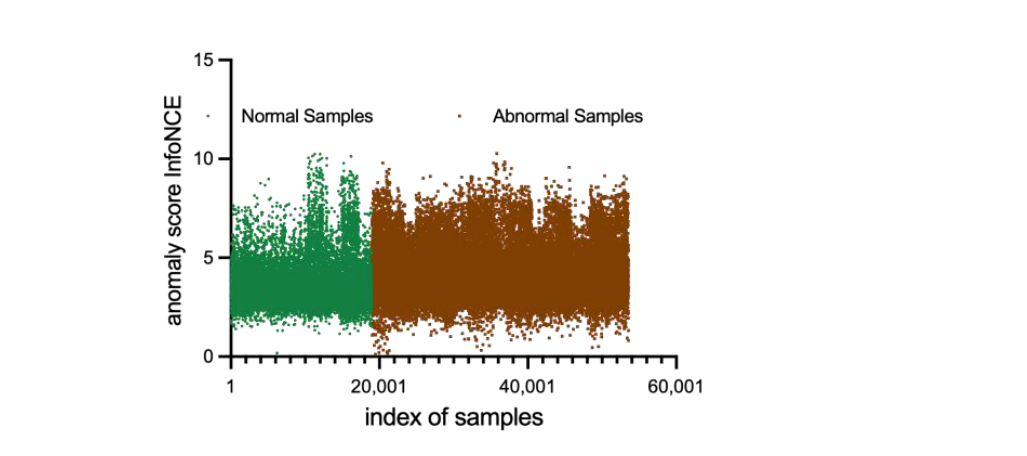
Figure 14. Anomaly scores of normal samples and abnormal samples, produced by CL-MMAD using InfoNCE loss, hyperparameter group 1.